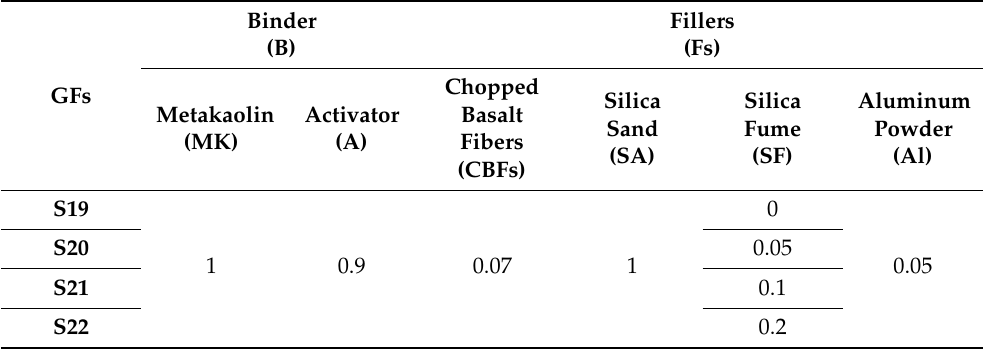
Table 2. The ratio of the GFs composition (binder—B, and fillers—Fs) is referred to